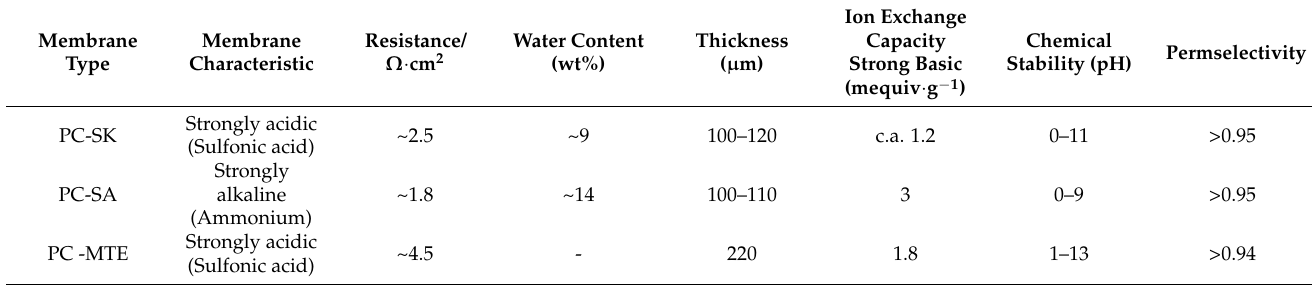
Table 2. Parameters of the experimental membranes according to the